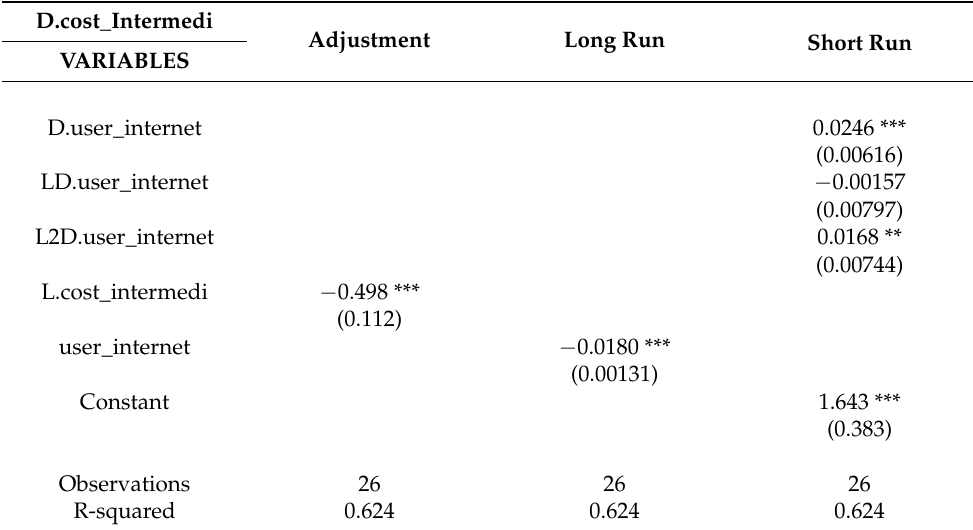
Table 6. Model 3—impact of digital transformation on financial services